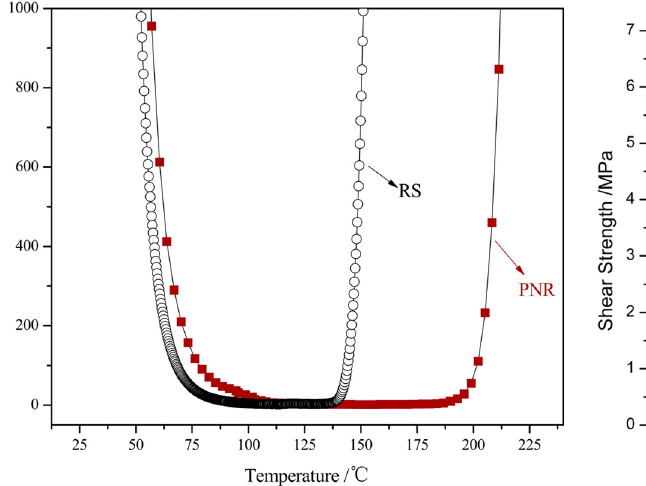
Figure 12: Shear strength of steel - steel bonds: ( a ) RT, ( b ) 350°C, (